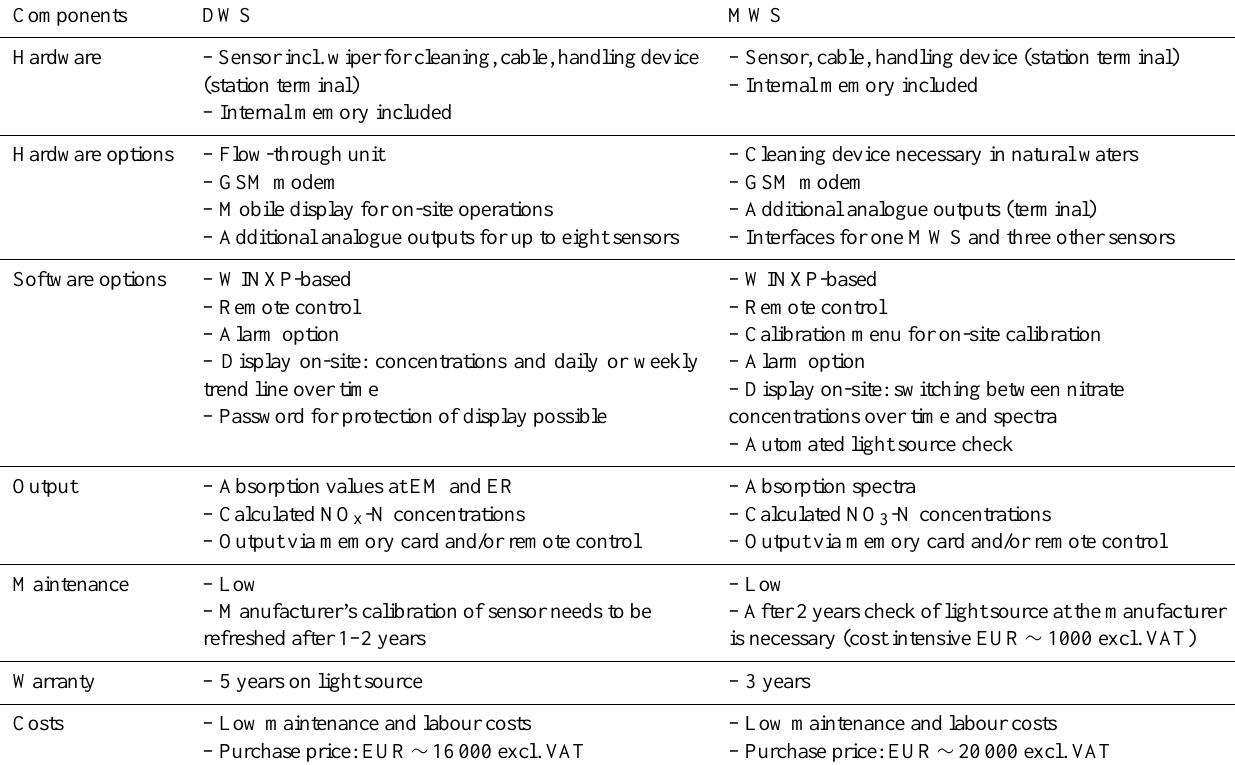
Table 1. Description of the double wavelength spectrophotometer (DWS) and the multiple wavelength spectrophotometer (MWS).